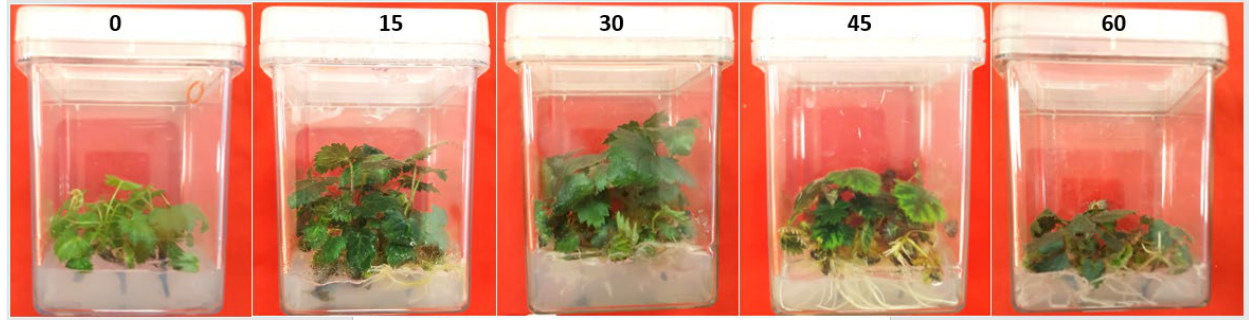
Figure 3. In vitro blackberry plantlets grown under blue + red light (2:1) and different sucrose concentrations (0–60 g L −1 ).